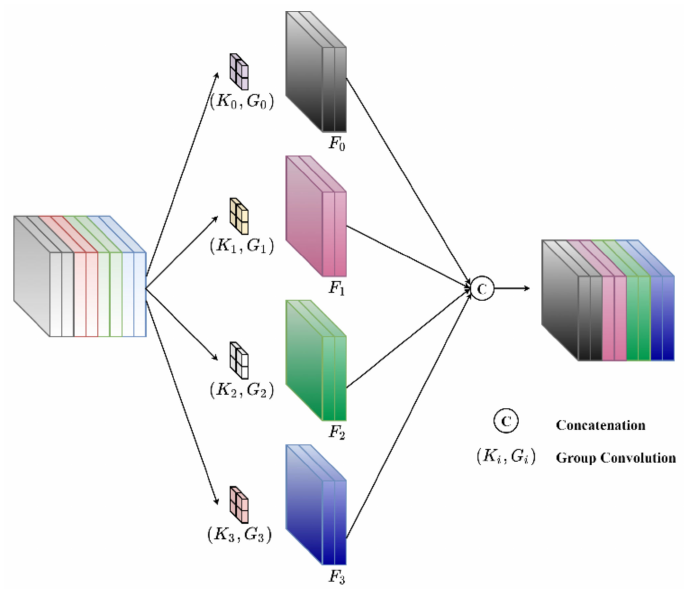
Figure 5. An example of the Pyramid Squeeze Mechanism module (PSM) with S = 4, where k refers to the kernel size and G represents the corresponding group